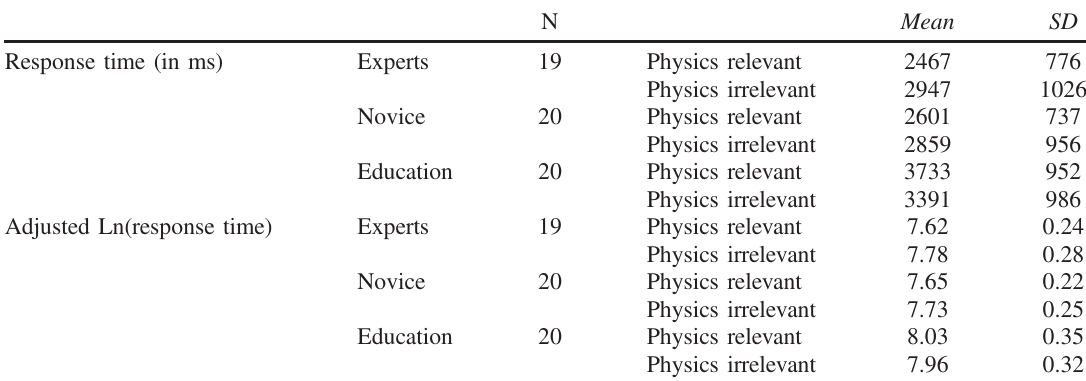
TABLE I. Means and SD of response time and adjusted Ln(response